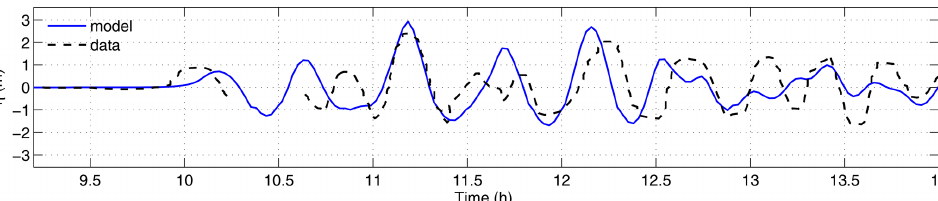
Figure 17. Same case as Fig. 15. Comparison between model result and measured data inside the Crescent City harbor, Crescent City,